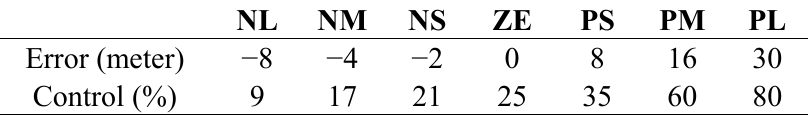
Table 6. Throttle Rule Inference.